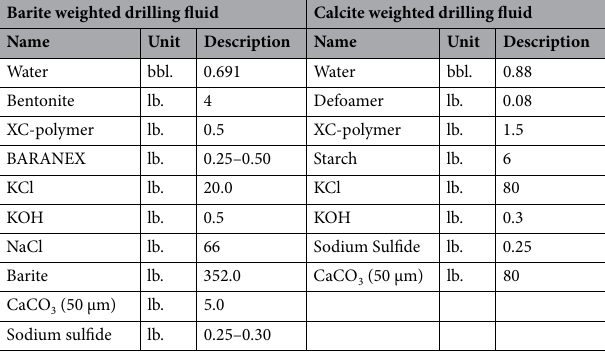
Table 1. Drilling fluid